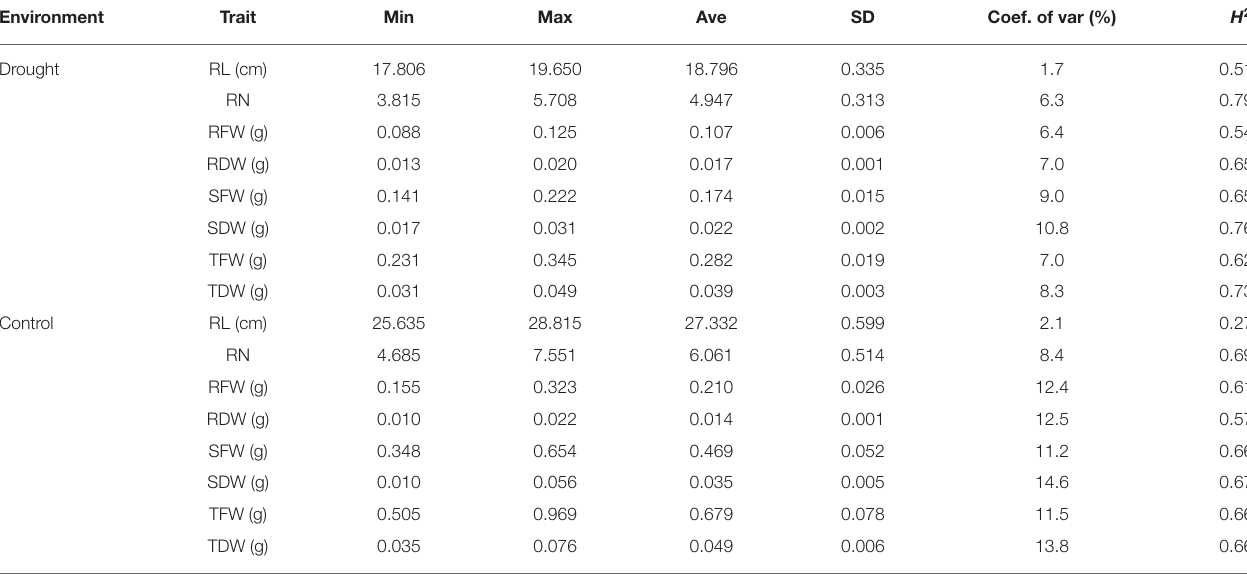
TABLE 1 | Basic statistics of root traits for 200 accessions grown in controlled and drought conditions. Environment